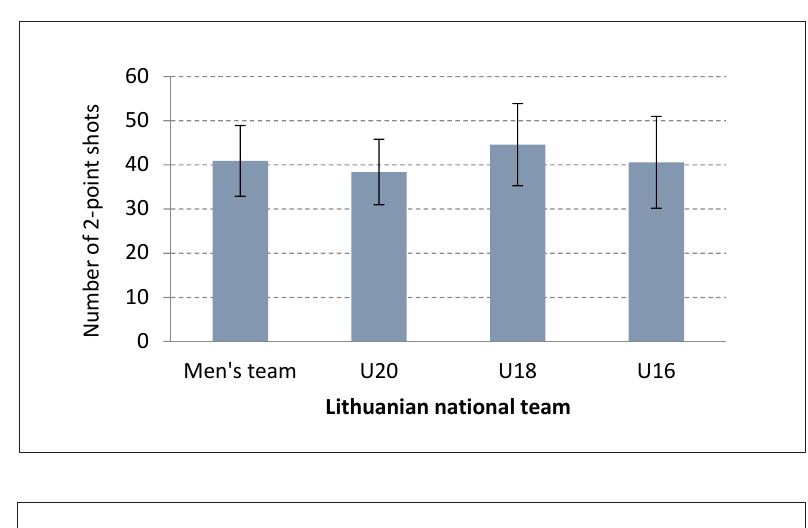
Figure 2. The accuracy of 2-point shots for men’s basketball teams in the European